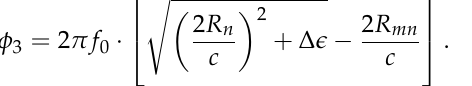
(for a specific offset 8